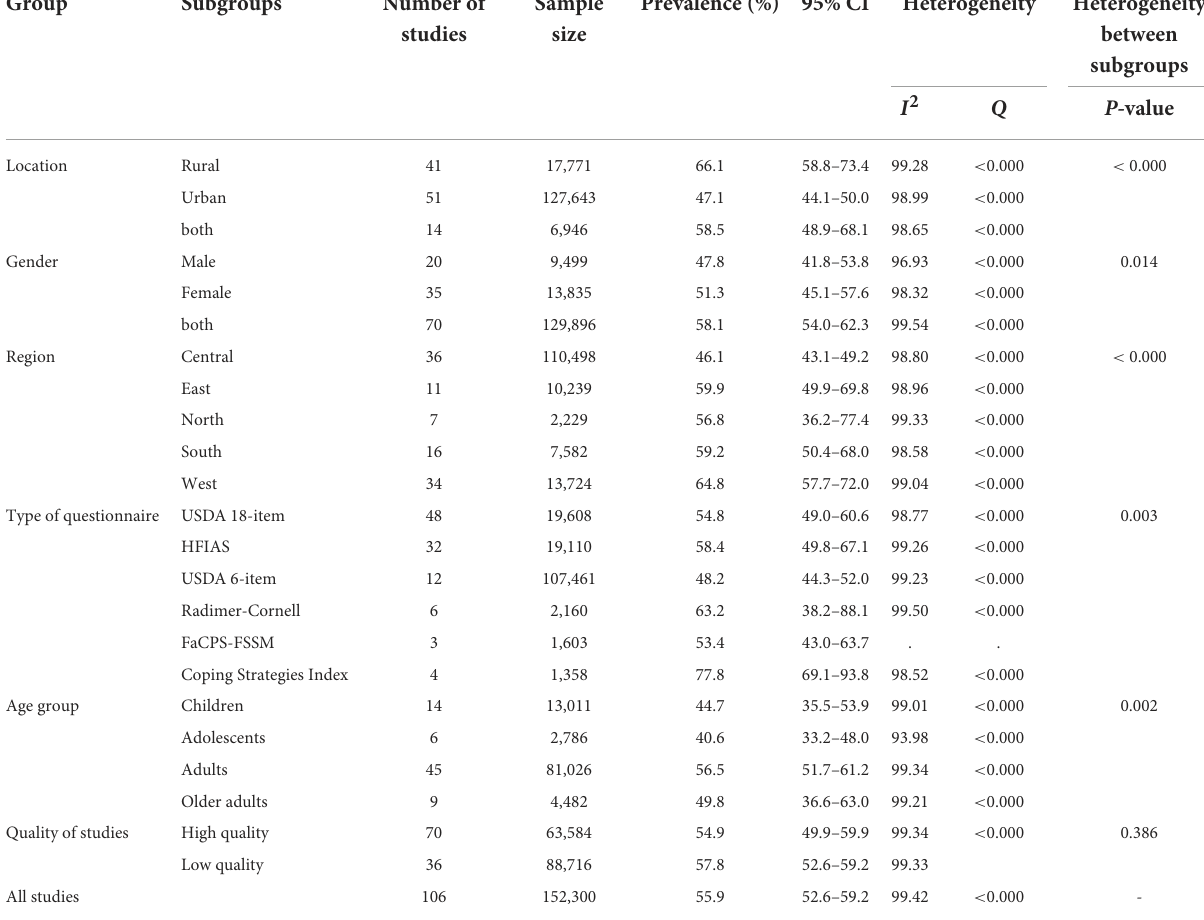
TABLE 2 Food insecurity prevalence data by location, sex, region, age group, quality of studies, and assessment tool.